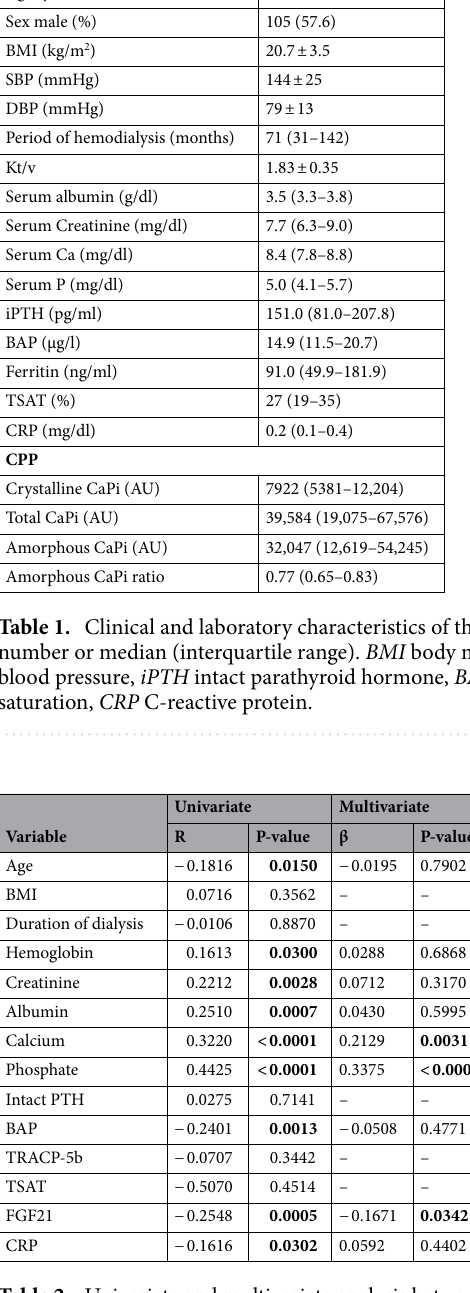
Table 2. Univariate and multivariate analysis between total CaPi amounts and serum parameters in the hemodialysis patients. Significant values are in bold. R coefficient of determination, β standardized partial regression